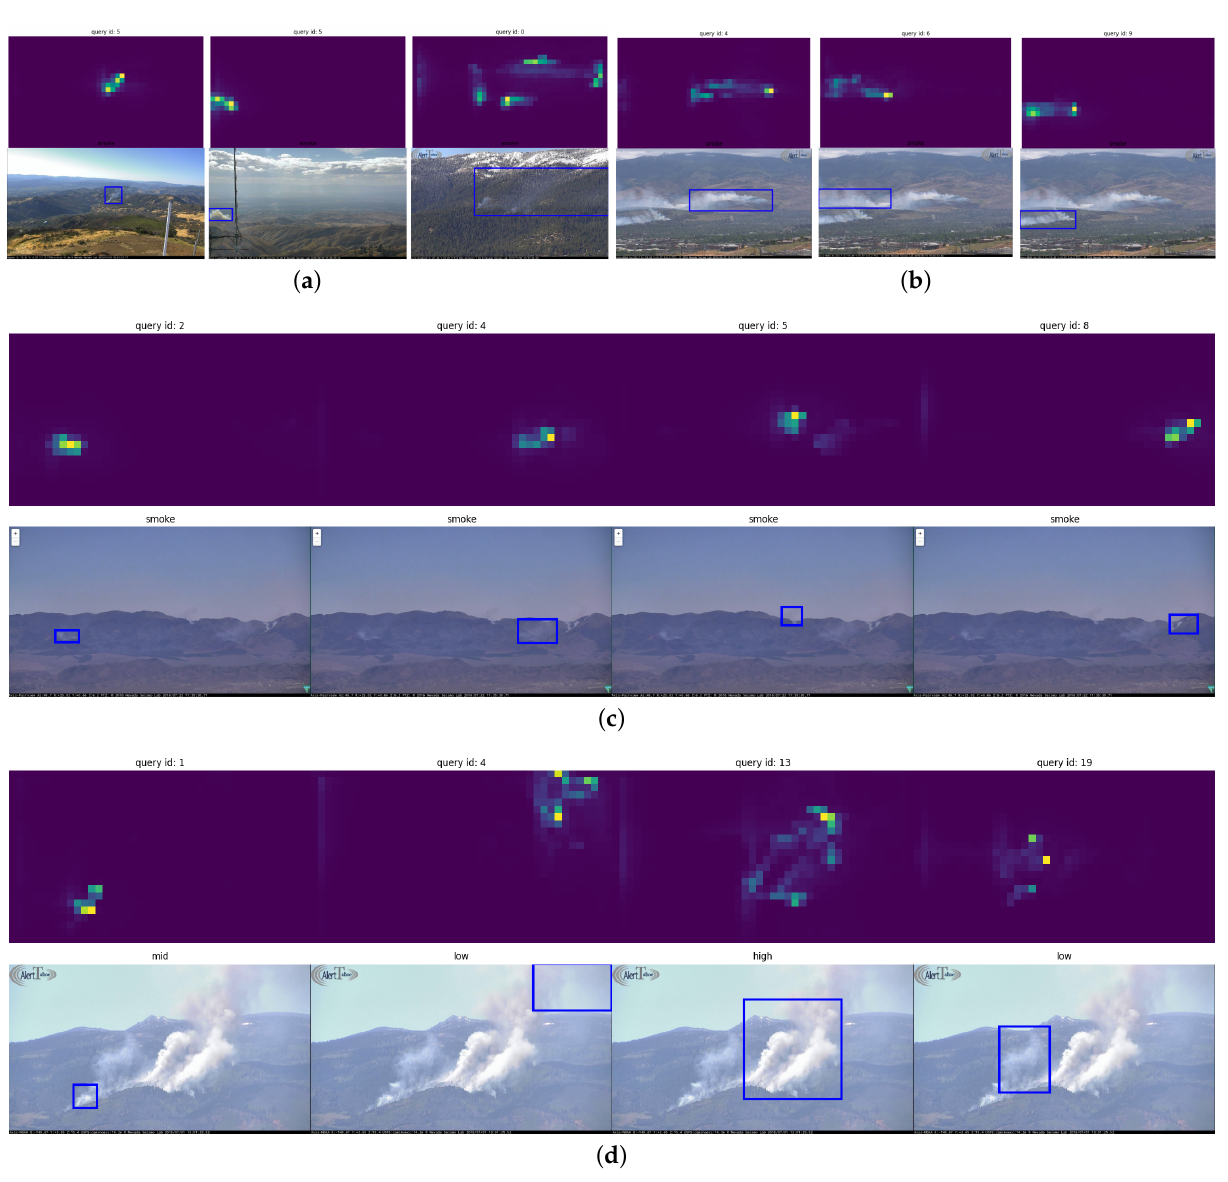
Figure 17. Representative examples of wildfire smoke predictions (lower images) and visualization of the decoder inter-attention for each prediction (upper image). Predictions were made with the base Nemo-DETR-sc and Nemo-DETR-d. The respective attention weights at the last decoder layer in the top part of each image show where in the image the model (i.e., object query) was looking at to predict each specific bounding box and class. This visualizes the effectiveness of attention-based models in finding smoke regions. ( a ) Smoke correctly detected in 3 different images. ( b ) Hawken fire: 3 smoke regions detected in 1 image. ( c ) Little Den fire, 4 small fires detected in 1 image. Each prediction is denoted with its associated bounding box (lower image) and encoder–decoder multi-head attention weights (upper image). ( d ) Example of smoke density prediction. Each predicted box is shown separately with the associated attention weight. Each object query has a predicted a bounding box, and their density was correctly